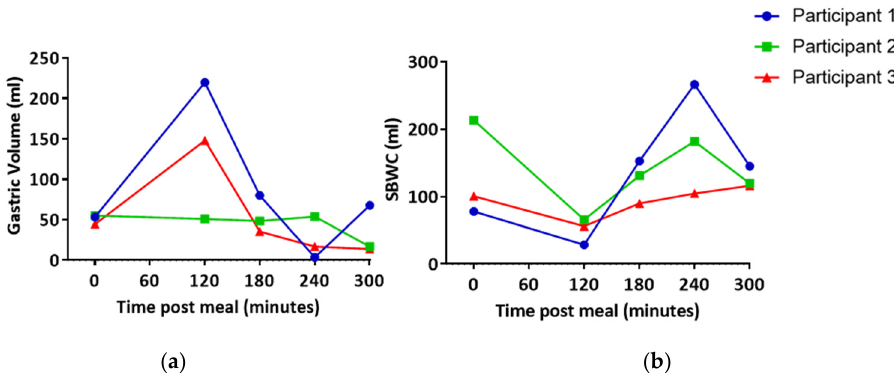
Figure 1. ( a ) Gastric volume and ( b ) small bowel water content (SBWC) post high fat meal. Each line represents data from an individual participant.